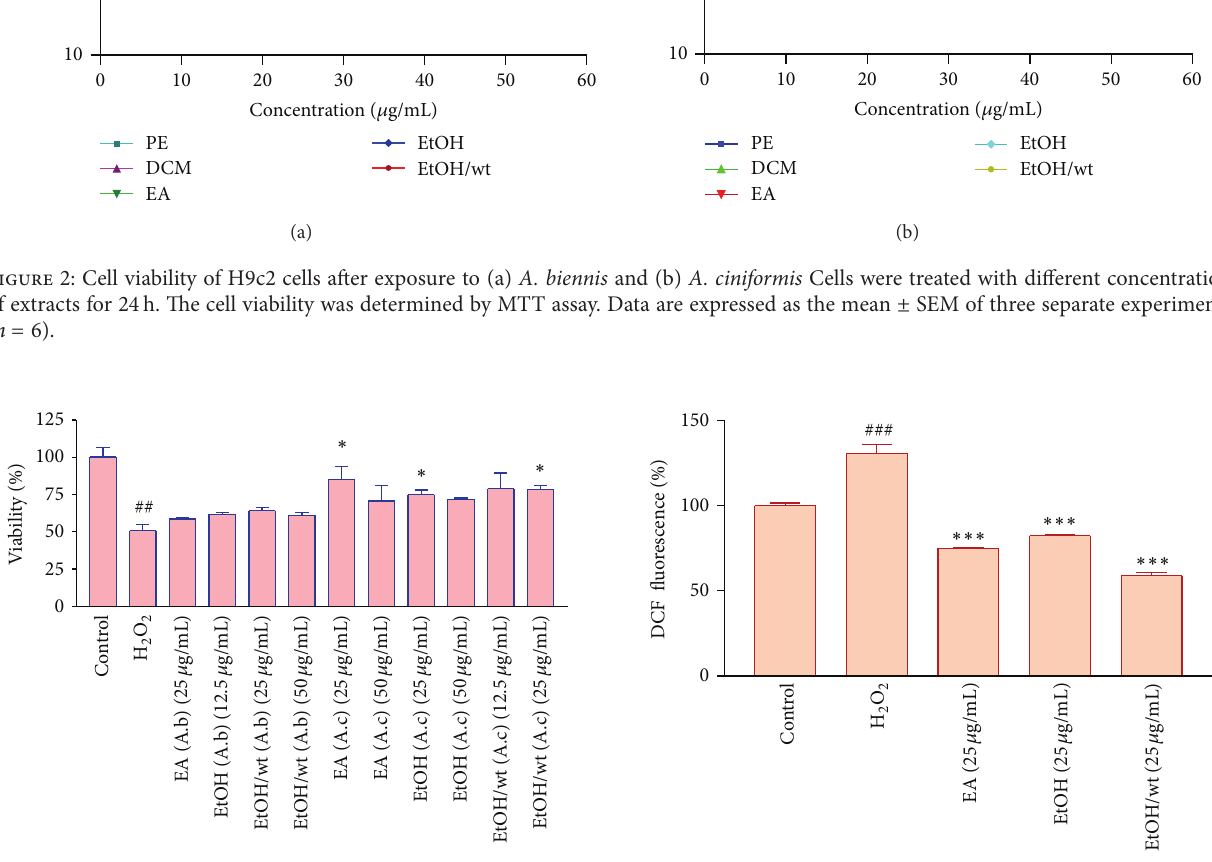
Figure 3: The effect of different extracts of A . biennis and A . cini- Figure 4: The effect of different extracts of A. ciniformis pretreat- formis on H 2 O 2 -induced cytotoxicity in H9c2 cells. Cell pretreated ment on H 2 O 2 -induced ROS generation. Data are expressed as the with different extracts of A. biennis and A. ciniformis for 24 h before mean ± SEM of three separate experiments ( 𝑛 = 4 ). ### 𝑃 < 0.001 exposureto62.5 𝜇 MofH 2 O 2 . Data areexpressed as themean ± SEM versus Control, and ∗∗∗ 𝑃 < 0.001 versus H 2 O 2 -treated of three separate experiments ( 𝑛 = 6 ). ## 𝑃 < 0.01 versus control, ∗ 𝑃 < 0.05 , versus H 2 O 2 treated cells.